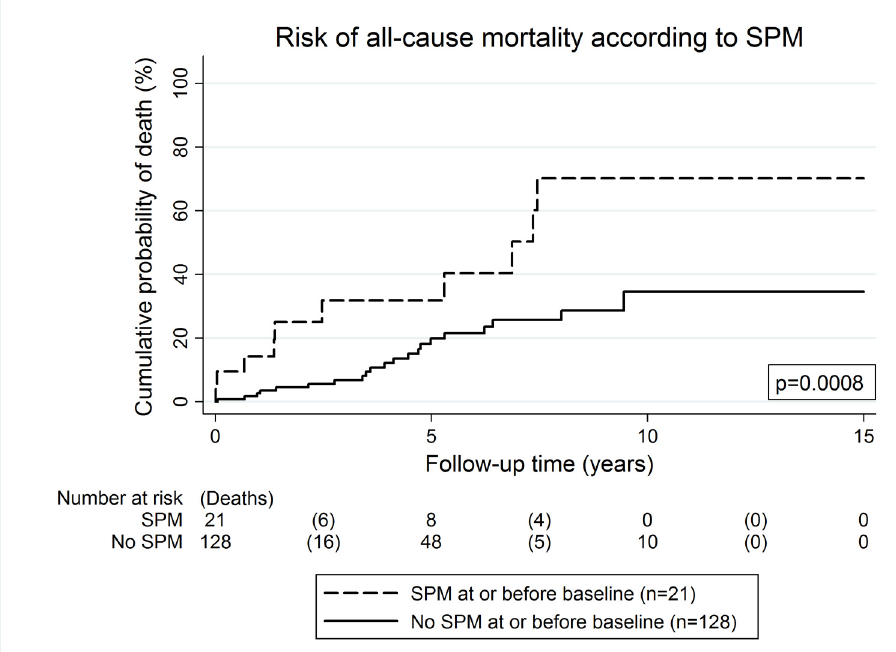
Fig 1. Risk of all-cause mortality according to second primary malignancy status (SPM) at baseline. The presence of a second primary malignancy (SPM) or a history of a SPM at baseline was a significant contributor towards an increased risk of death-from-any-cause. The risk of death was estimated using the inverse Kaplan-Meier estimator, and the boxed p-value using a log-rank